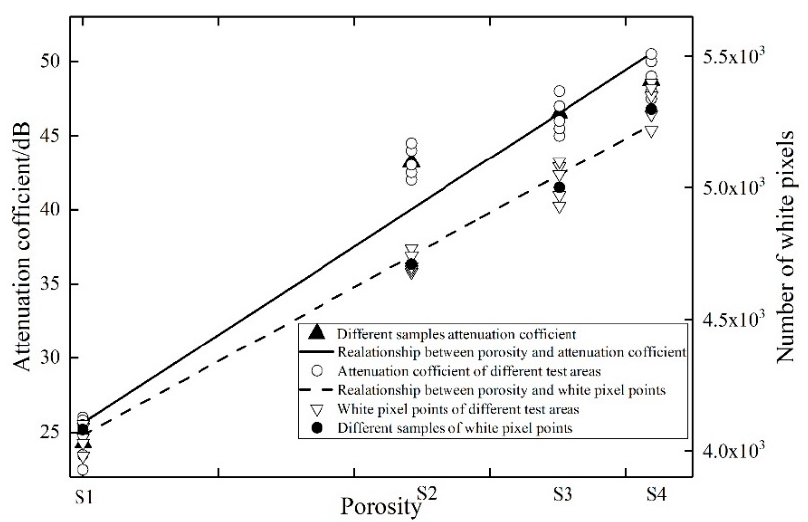
Figure 9. The relationships between the attenuation coefficient or the number of white pixels and the porosity.